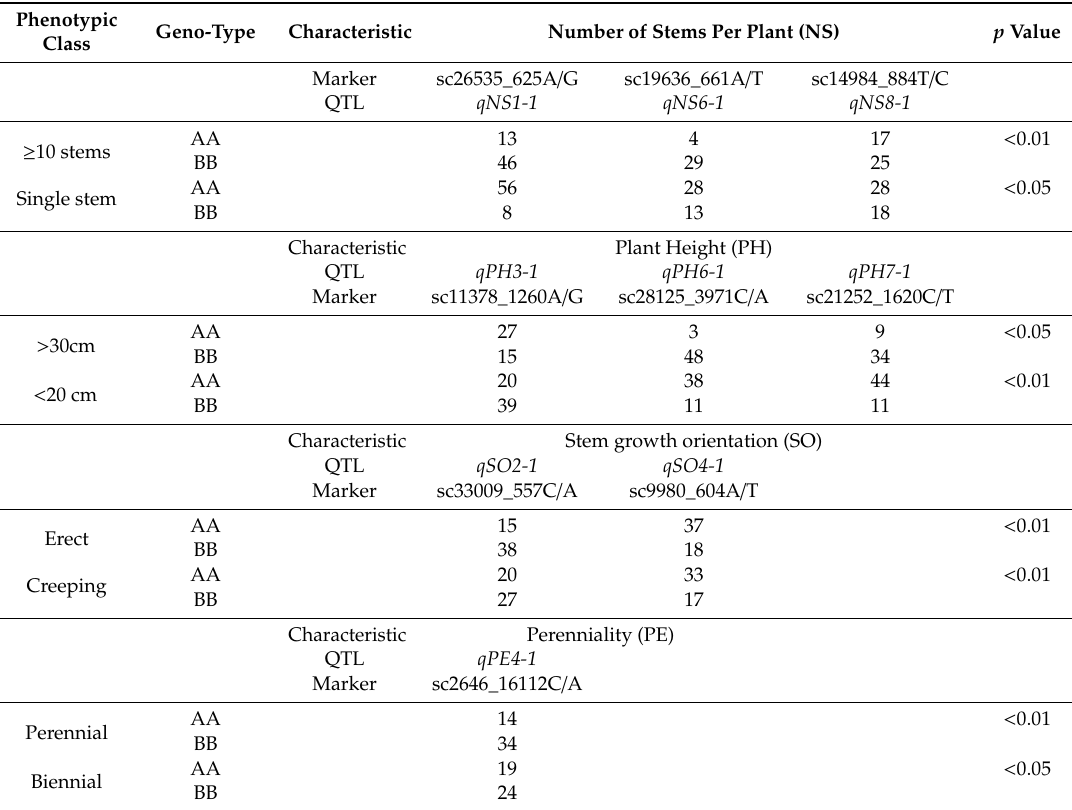
Table 5. Percentage of plants within a phenotypic class that are AA or BB homozygote for the left flanking markers of each of the nine QTLs across the four